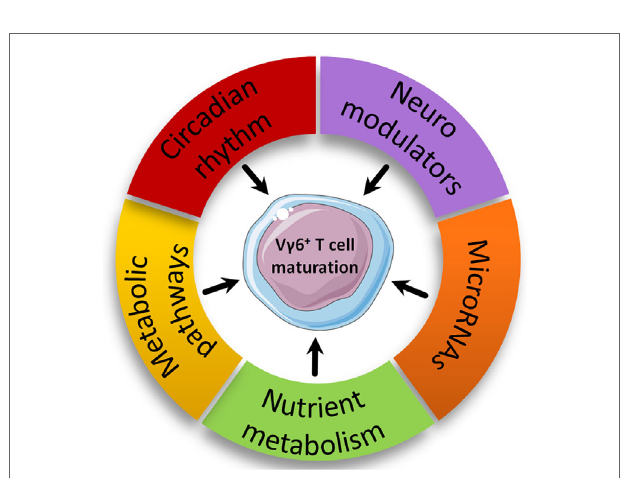
FiguRe 4 | Proposed new biological pathways involved in intrathymic V γ 6 + maturation. Biological pathways with enriched modulated genes in the V γ 6 + dataset are represented based on advanced pathway analysis using the trial version of iPathwayGuide ( © Advaita Corporation).